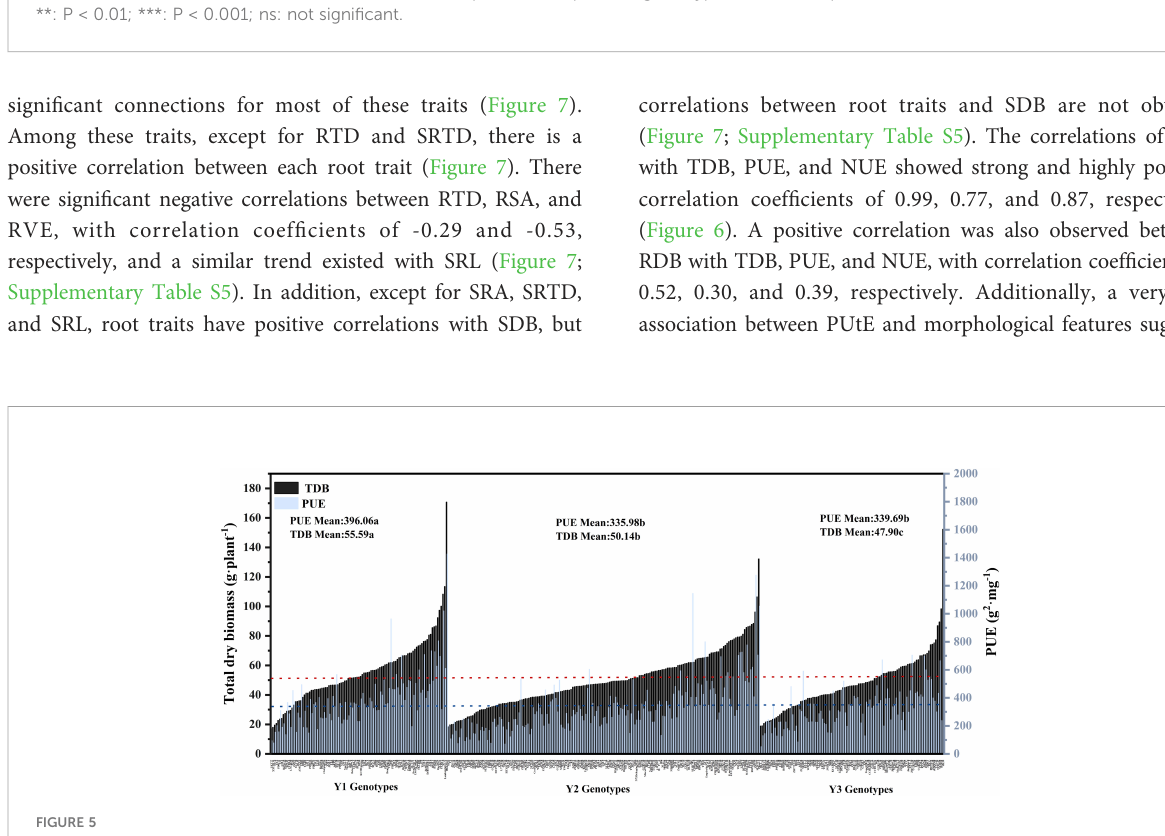
FIGURE 5 Genotypic variation in PUE and TDB relative value of 384 cotton genotypes grown in a hydroponic phenotyping platform. Mean values were plotted by three groups of genotypes: 101 Y1 genotypes, 177 Y2 genotypes, and 105 Y3 genotypes. (Y1: breeding years before 1980, 101 varieties in total, no chemical fertilizer stage of cotton production.Y2:breeding years: 1981-2000, 177 varieties in total, cotton production (small amount of chemical fertilizer stage).Y3: from 2001 to now, there are 105 varieties in total, and cotton production is at the stage of excessive chemical fertilizer). The mean values of PUE for each genotype group (colored bars) and all genotypes (blue dashed line) are presented. The mean values of TDB for each genotype group (colored bars) and all genotypes (red dashed line) are shown.